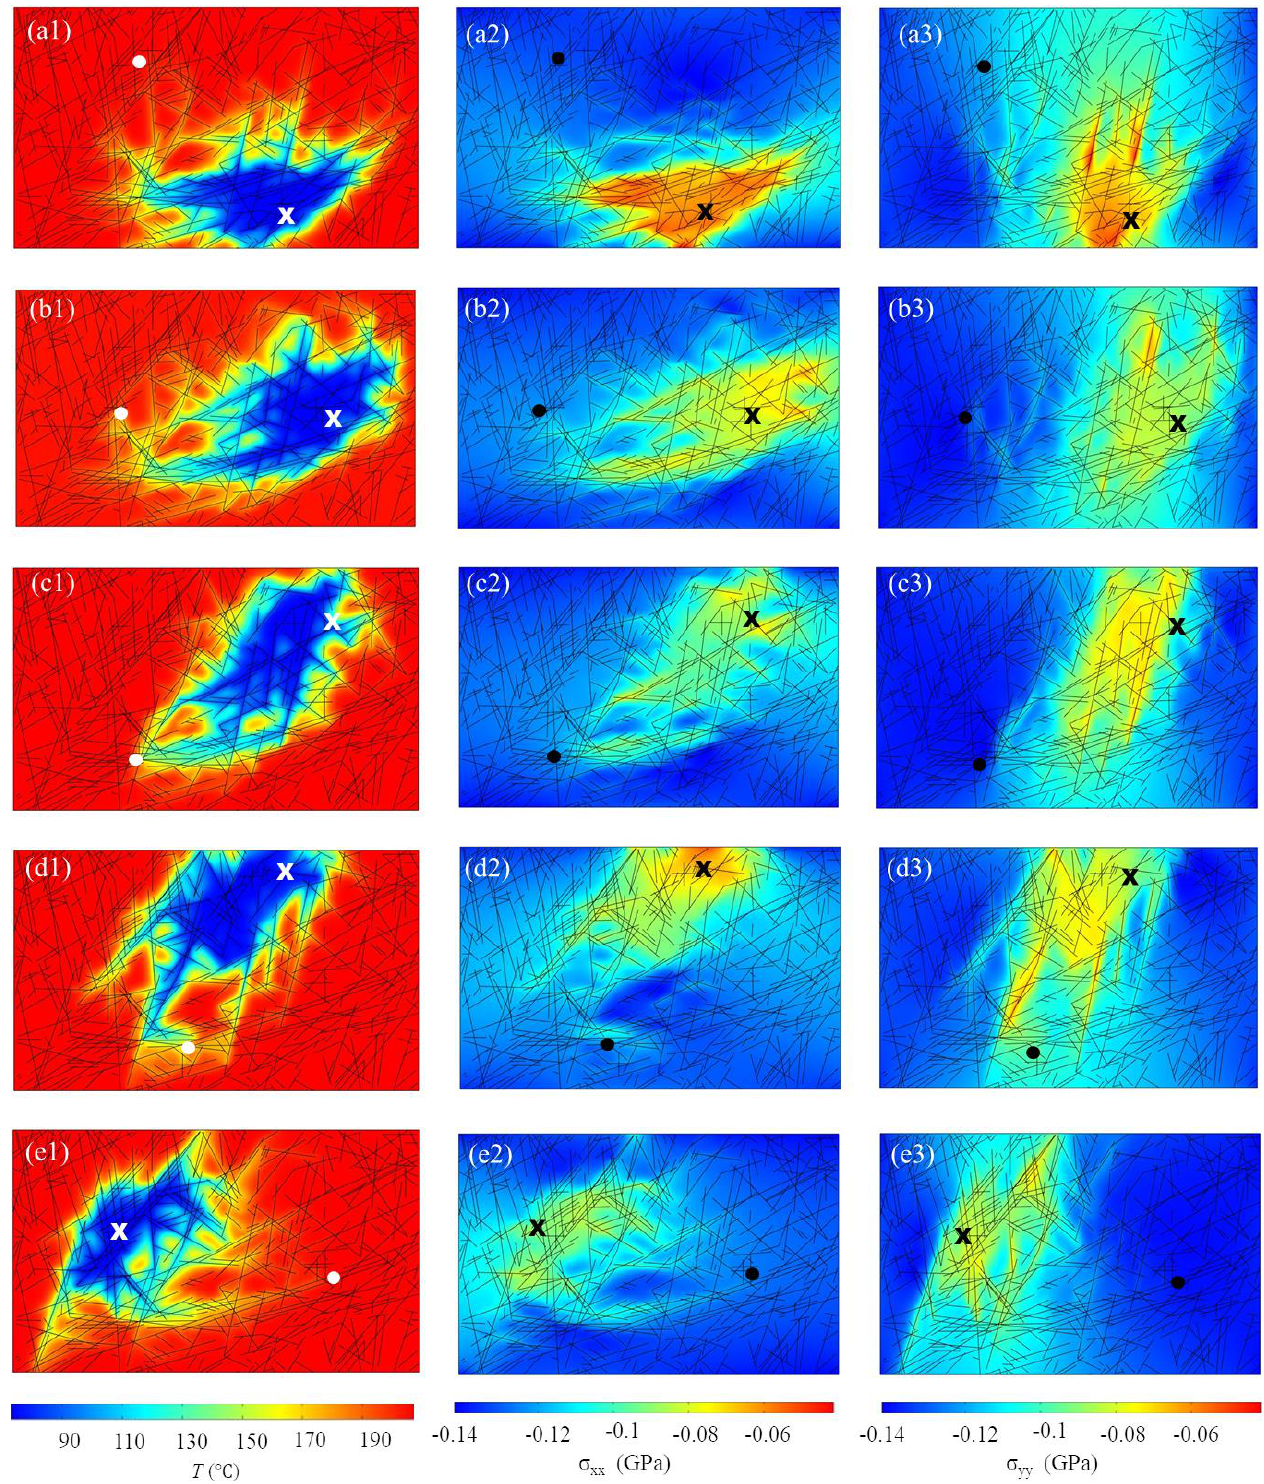
Figure 8. Distribution of ( a1 – e1 ) reservoir temperature, ( a2 – e2 ) horizontal thermoelastic stress and ( a3 – e3 ) vertical thermoelastic stress when water is used as the working fluid. Here Case 130 is displayed by ( a1 – a3 ), Case 180 is displayed by ( b1 – b3 ), Case 220 is displayed by ( c1 – c3 ), Case 250 is displayed by ( d1 – d3 ), and Case 350 is displayed by ( e1 – e3 ). All contours are plotted at ten years. The injection wellbore position is shown by cross symbol whereas a circle indicates production wellbore position.